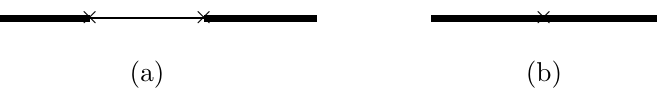
Figure 1 . The two Feynman diagrams that contribute to the disk two-point amplitude. The thick lines denote closed strings, while the thin line denotes an open string. The first diagram gives the moduli space integral over the range 0 ⁄ y ⁄ (cid:15) , and the second diagram gives the contribution from the range (cid:15) ⁄ y ⁄ 1 . Figure reproduced from